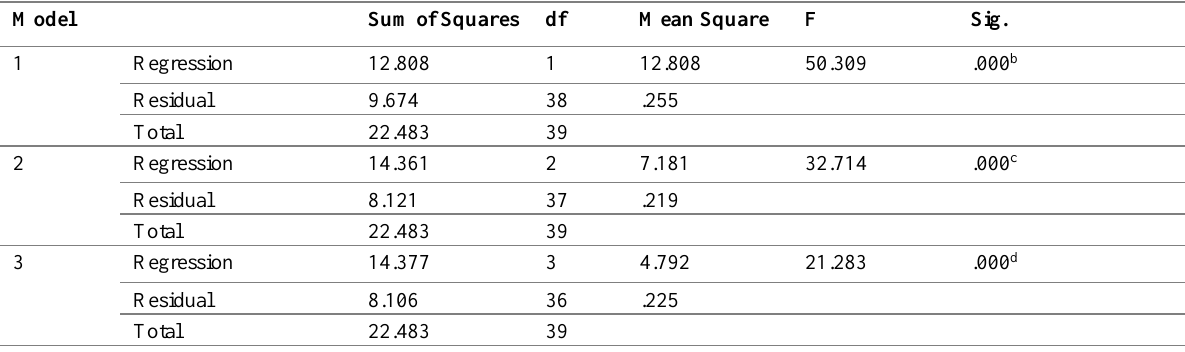
Table 4: ANOVA a Results